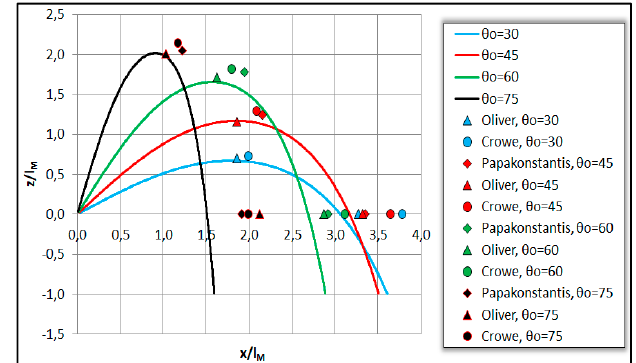
Figure 5. Comparison between model and experimental results regarding the trajectory of negatively buoyant saline jets.